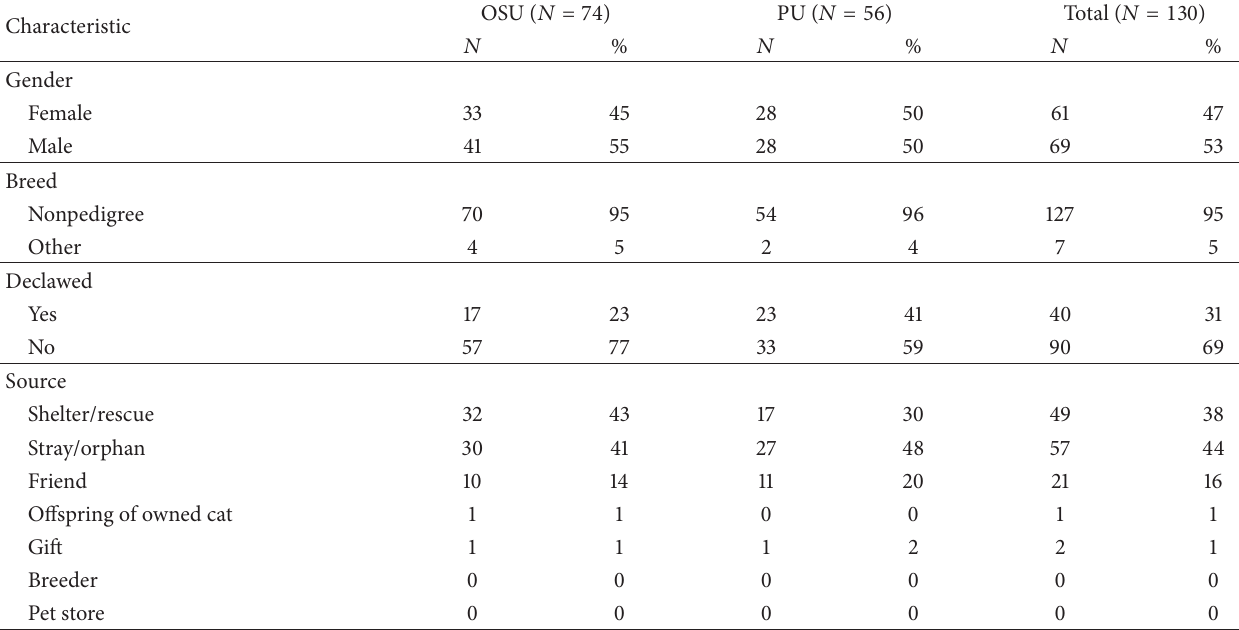
Table 1: Cat signalment and demographic information of the subjects.